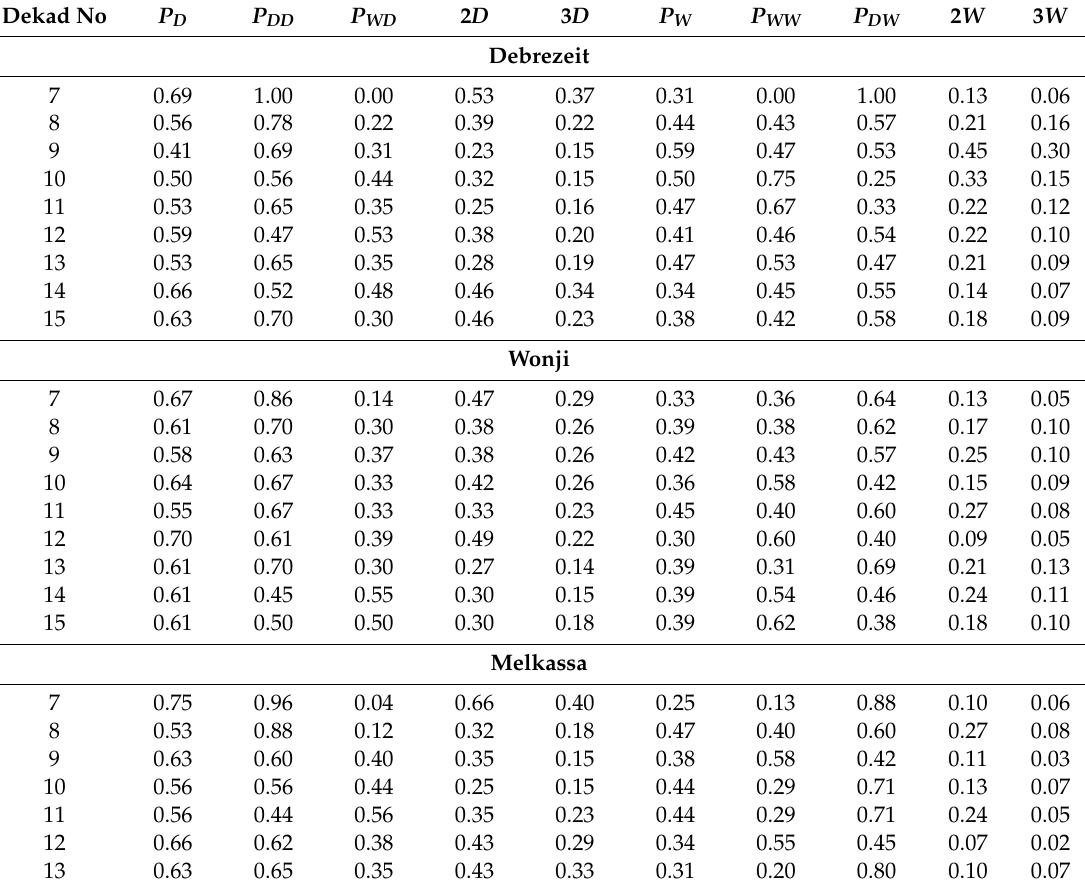
Table A2. Probabilistic distribution of dry and wet spells in the Belg season. Dekad